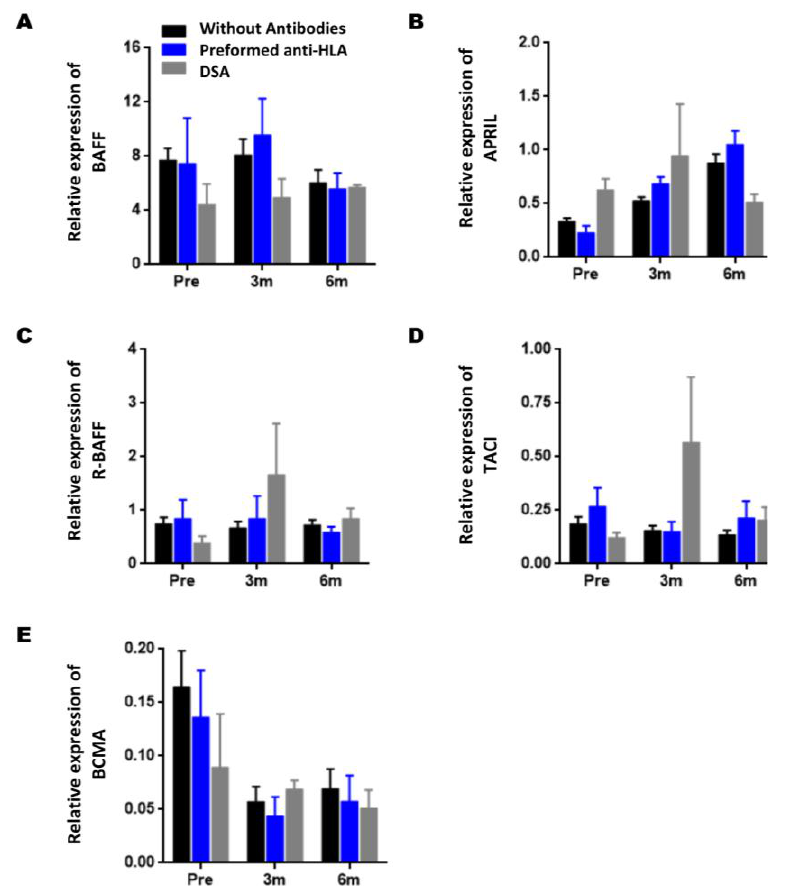
Figure 7. Association of the gene expression of BAFF, APRIL, and their receptors (R-BAFF, TACI, and BCMA) with anti-HLA antibodies status. Comparison of BAFF ( A ), APRIL ( B ), R-BAFF ( C ), TACI ( D ), and BCMA ( E ) gene expression levels in peripheral blood samples among KTRs without anti-HLA antibodies (black, n = 30), preformed anti-HLA antibodies (blue, n = 6) at pre-transplantation, and with de novo DSA antibodies (gray, n = 4). The HPRT gene was used as an endogenous control to normalize BAFF and APRIL gene expression, and the CD19 to normalize R-BAFF, TACI, and BCMA gene expression. Expression data are represented as the mean ± SEM. Statistical analyses were performed using the Kruskal–Wallis test and Dunn’s post hoc test with Bonferroni correction for multiple comparisons. Values p < 0.05 were considered significant.